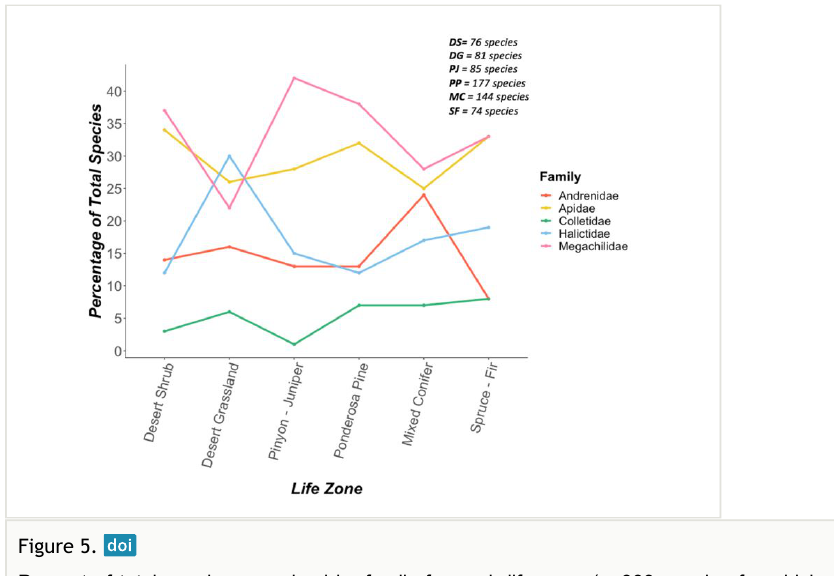
Figure 5. Percent of total species organized by family for each life zone (n=339 species for which we had accurate locality data to assign life zone designations). DS = desert shrub, DG = desert grassland, PJ = pinyon-juniper, PP = ponderosa pine, MC = mixed conifer, SF = spruce-fir. Numbers for each life zone sum to